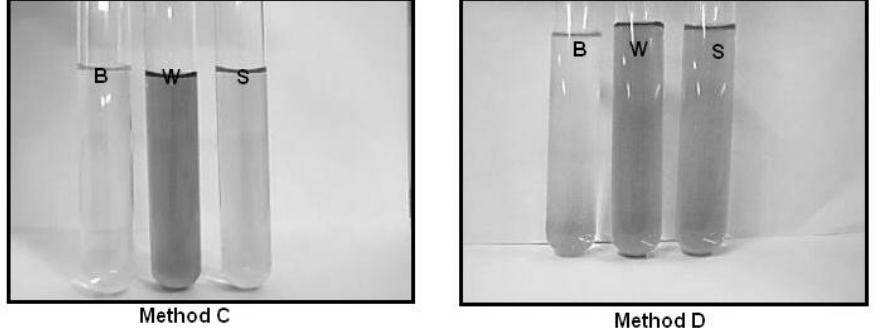
Figure 6. Final colour of sample and interference of excess sodium nitrite.